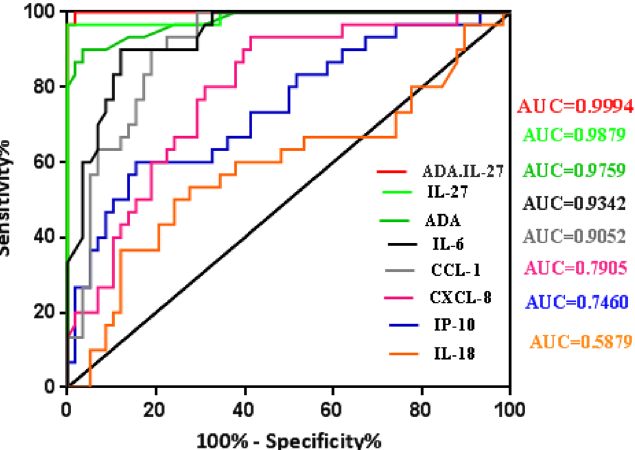
Figure 3. ROC curve of ADA, IL-27, ADA-IL-27, IL-6, IL-18, CXCL8, CCL1 and IP-10 for differential diagnosis of TPE (n = 30) versus non-TPE (n = 58).